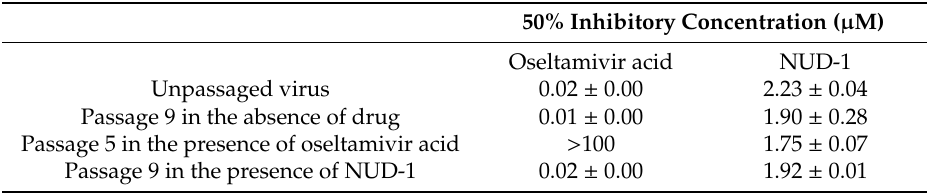
Table 1. Sensitivity of the passaged A / California / 7 / 2009 virus to oseltamivir acid and